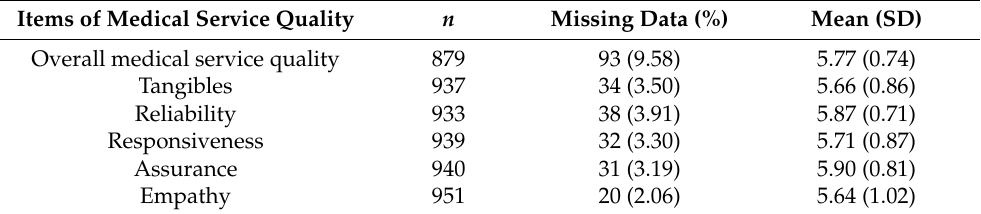
Table 3. Respondents’ medical service quality.